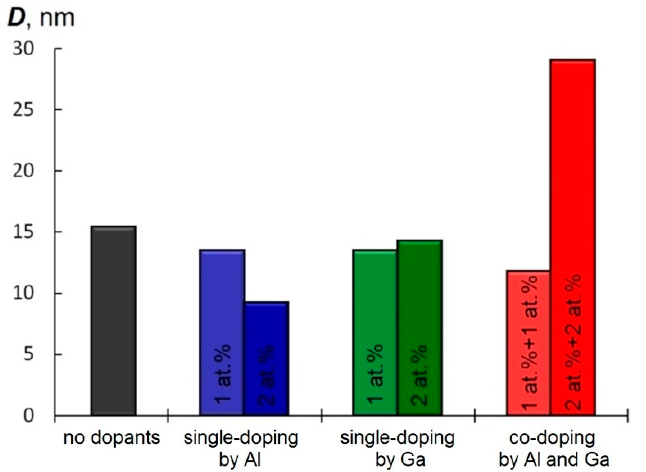
Figure 4. Average grain size of the deposited ZnO-based thin films deposited at substrate temperature 300 °C.